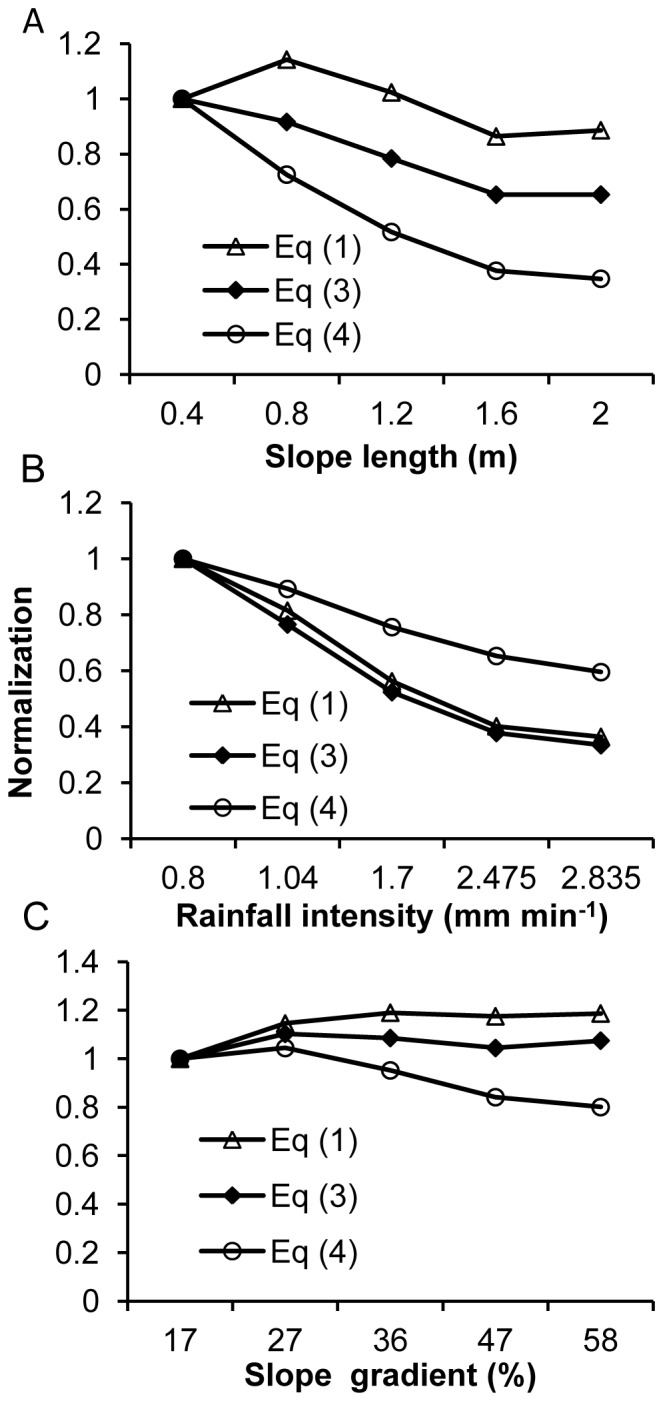
Normalized interrill erodibilities.Variations in interrill erodibility for the three equations for different slope lengths (A), rainfall intensities (B), and slope gradients (C), normalized to the lowest values of the independent factors.